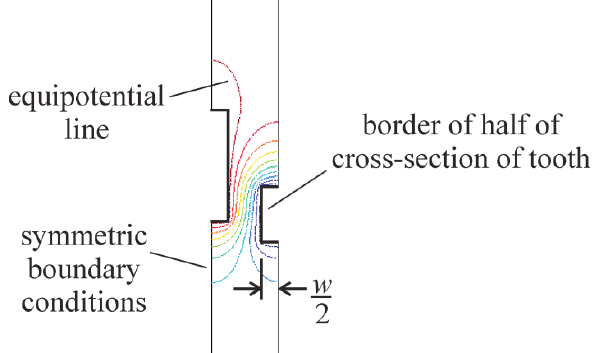
Figure 5. One of the finite element models that includes the width of the comb teeth.